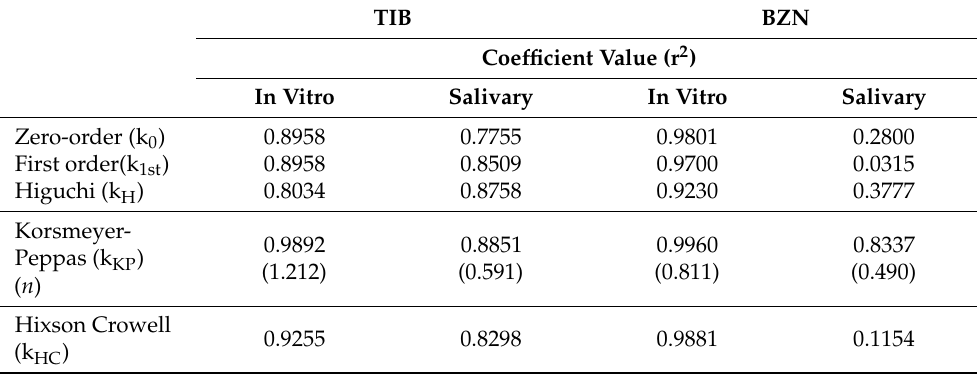
Table 3. In vitro release kinetics of BZN and TIB from optimized (F10) formulation.